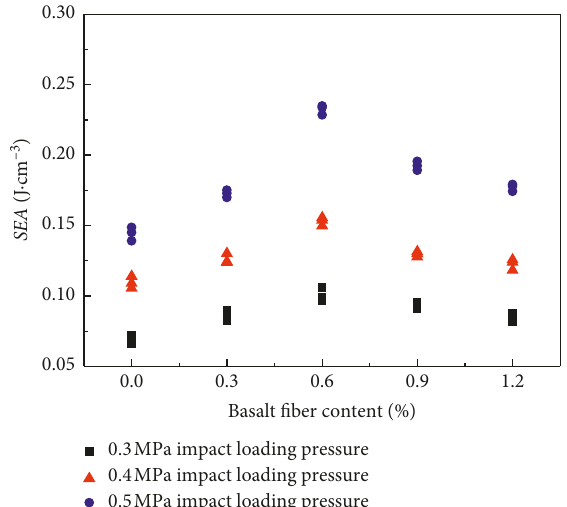
Figure 16: Relationship between specific energy absorption and basalt fiber content.